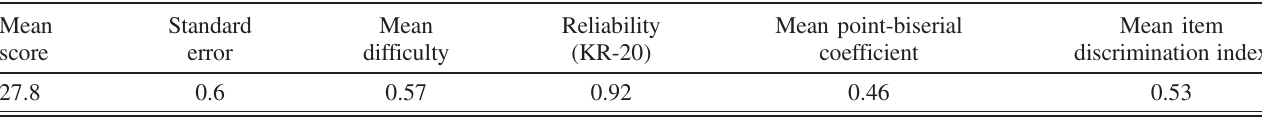
TABLE IV. Overall test results from the final 49-item-version of the test, taken from a sample of 338 post-instruction Gymnasium students. The score is the number of correctly solved